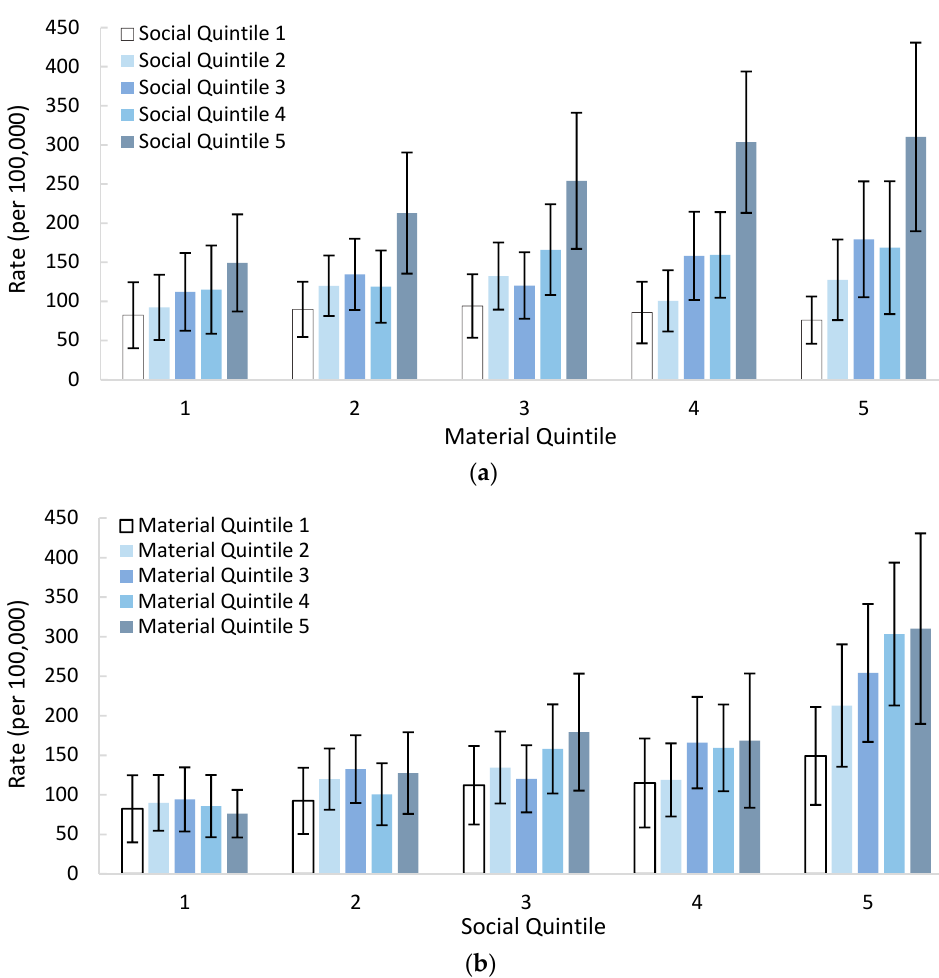
Figure 2. Self-poisoning hospitalization rates per 100,000 population in BC among 10–19-year-olds, 1 April 2012 to 31 March 2020, by: ( a ) social quintile controlling for material quintile; ( b ) material quintile, controlling for social quintile. Error bars display 95% confidence intervals.